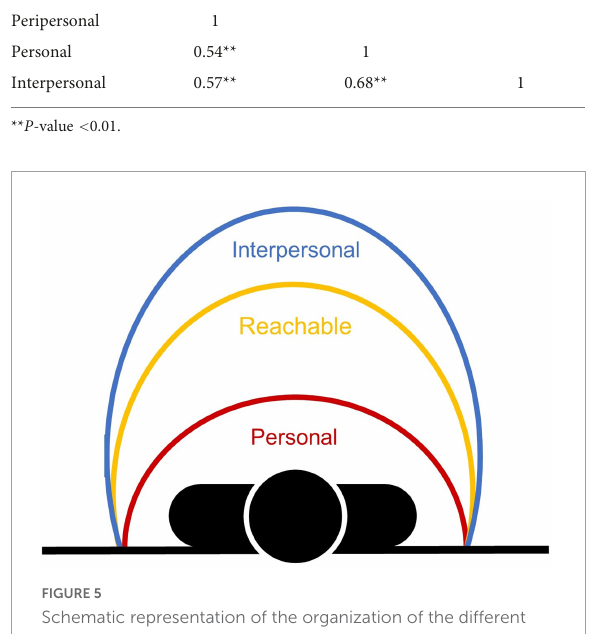
FIGURE5 Schematic representation of the organization of the different